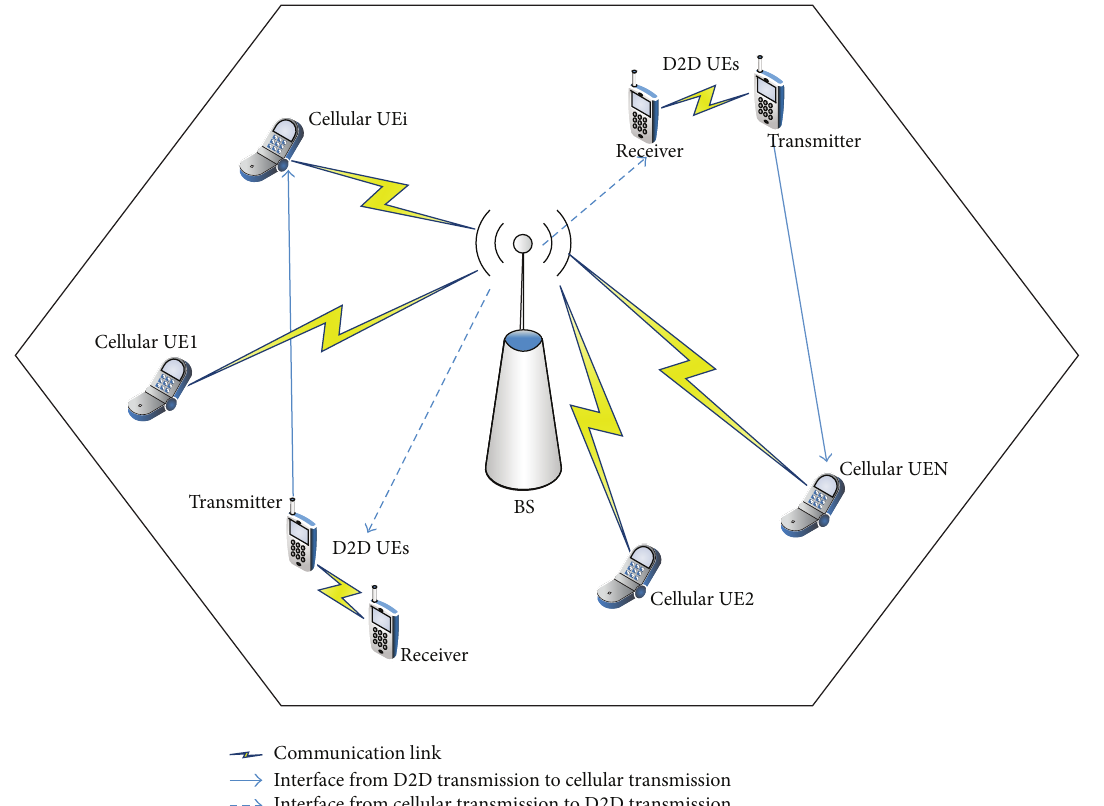
Figure 1: System model for D2D communications underlaying cellular network when sharing downlink